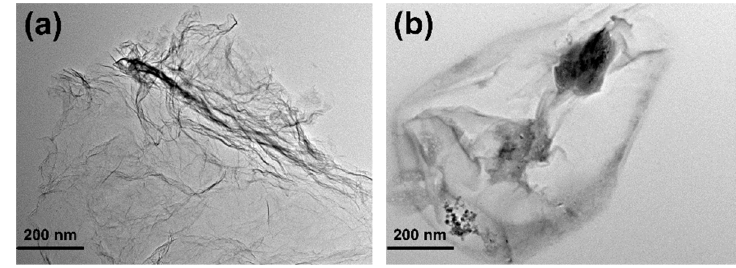
Figure 2. TEM images of ( a ) GO and ( b ) GO-H202.